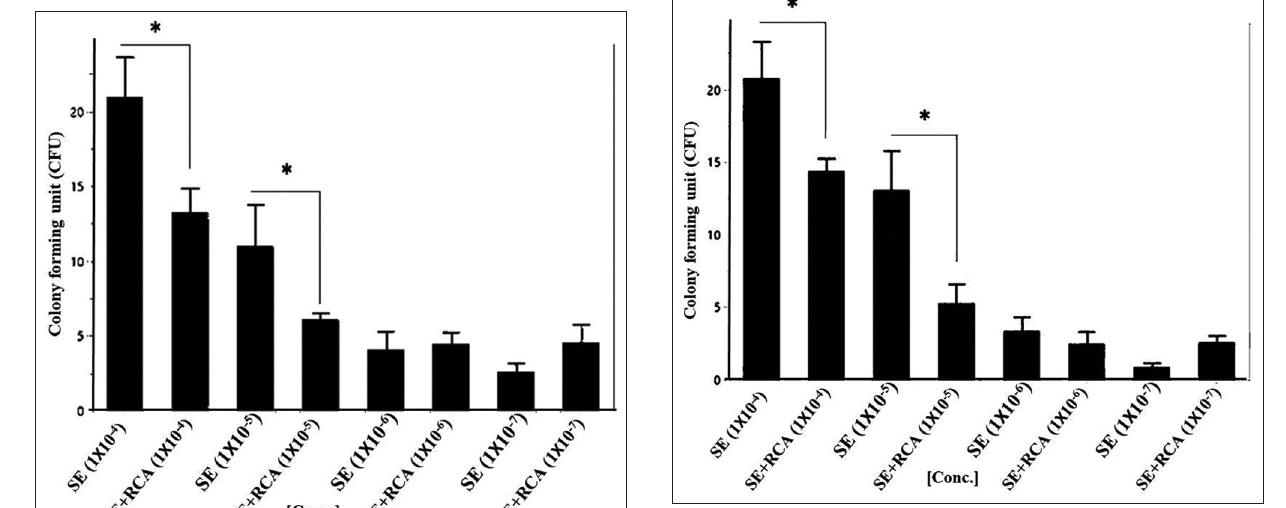
Figure-5: Salmonella Enteritidis (SE) on Luria-Bertani (LB) agar. The bacterial isolate in broth was 10-fold serially-diluted and mixed with a constant concentration of anti- Salmonella DNA aptamers in the form of rolling circle amplification. The colony-forming unit on the LB agar was calculated and blotted with a concentration of the rolling circle amplification (RCA) products. The RCA products showed a significant ability to reduce the growth of the bacteria (p<0.001) in the higher bacterial concentrations, that is, 1×10 –4 and 1×10 –5 .